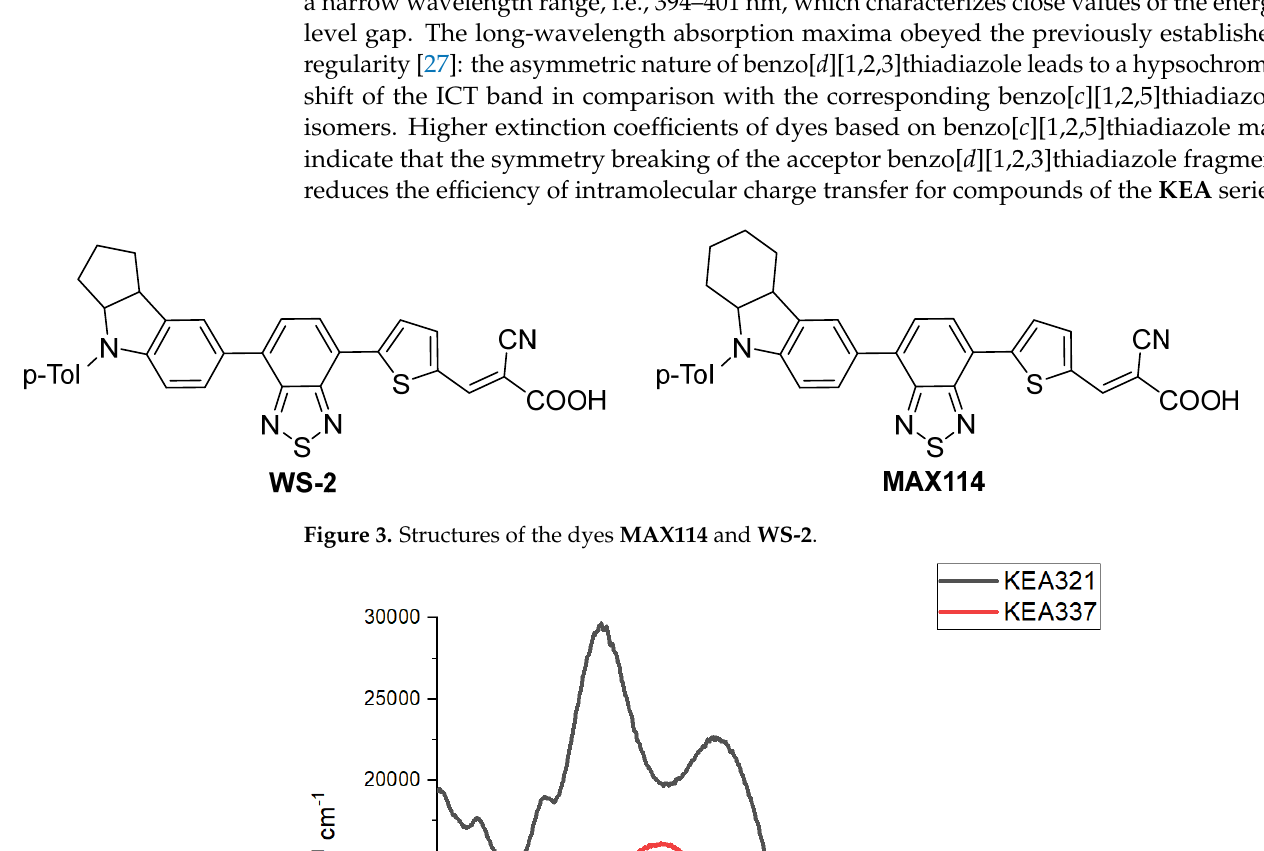
Figure 5. CV curves of KEA321 and KEA337 in DMF solution (0.1 М Bu 4 NClO 4 ) on platinum elec- trode at 0.1 Vs − 1 potential sweep rate.